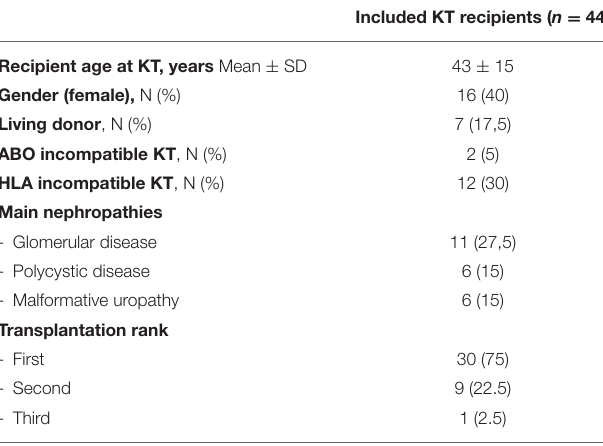
TABLE 1 | Demographic characteristics of included KT